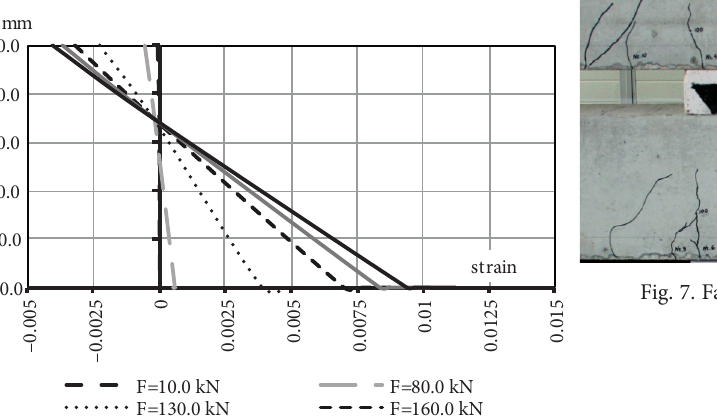
Fig. 4 Relationship between stresses of GFRP and actual bending moment